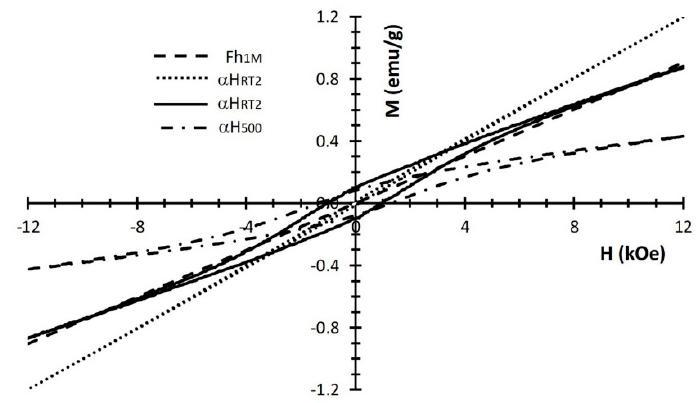
Figure 10. Hysteresis loops of different samples synthetized from 1M concentration of the aqueous ferric chloride solution: As synthetized (Fh 1M ), aged two months at RT (H RT2 ), aged seven months at RT (H RT7 ), and calcined at 500 °C (H 500 ).